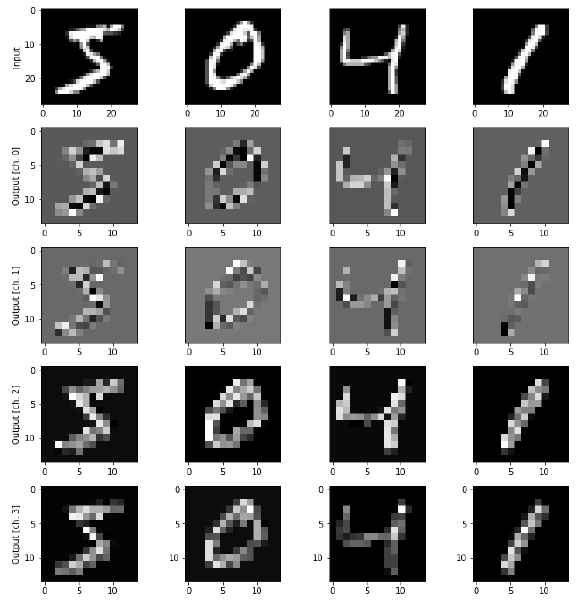
Figure 3. Example MNIST dataset images and corresponding output features using NNQE circuit model.